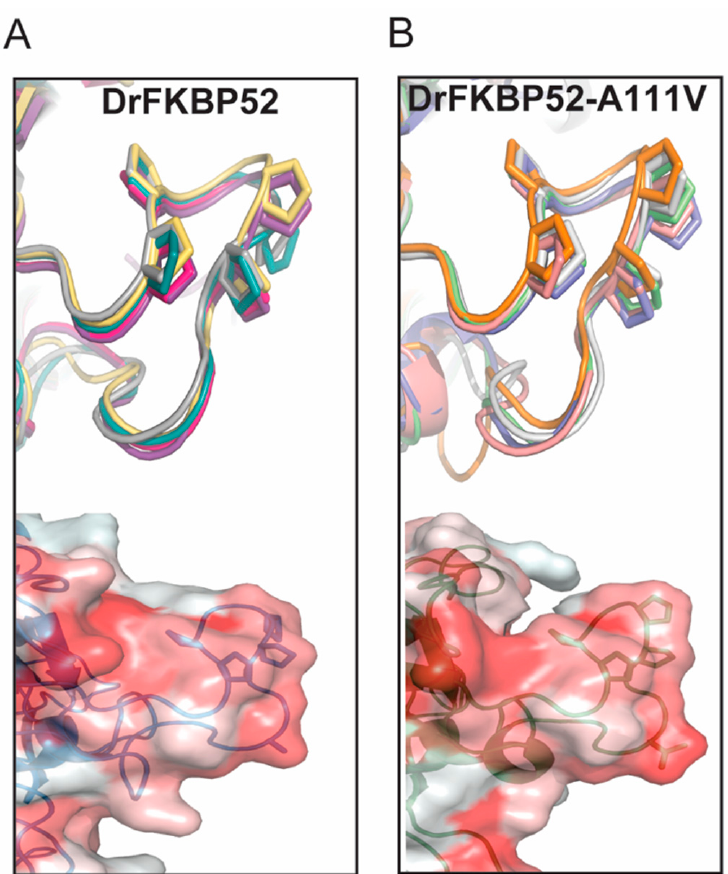
Figure 5. Predictive modeling and hydrophobicity scale of DrFKBP52 and DrFKBP52-A111V. The top structures represent the top five 3D models for each structural query of DrFKBP52 ( A ) and DrFKBP52-A111V ( B ) predicted by I-TASSER. The hydrophobicity on the surface of the loop was assessed (red = hydrophobic) in DrFKBP52 ( A ) and DrFKBP52-A111V ( B ) to allow us to further evaluate the structural changes that may be relevant in their functional divergence (bottom structures).